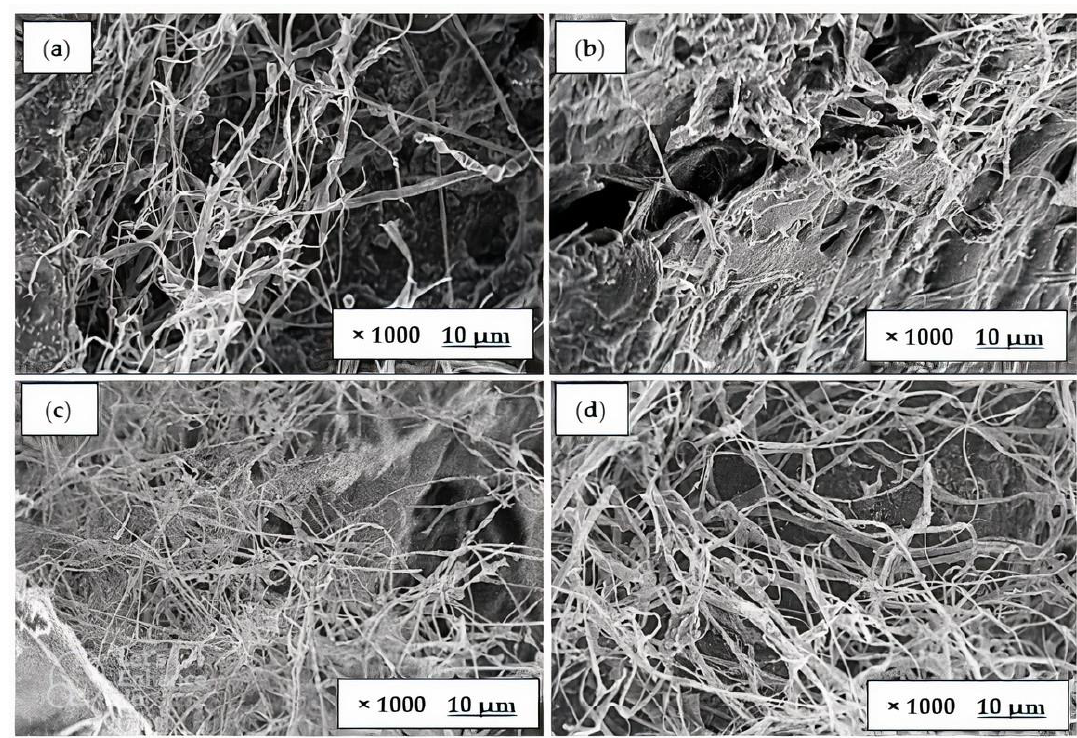
Figure 5. Morphology of fungal foam using Pleurotus florida in ( a ) rice husk, ( b ) sawdust, ( c ) sugarcane bagasse, and ( d ) teak leaves.